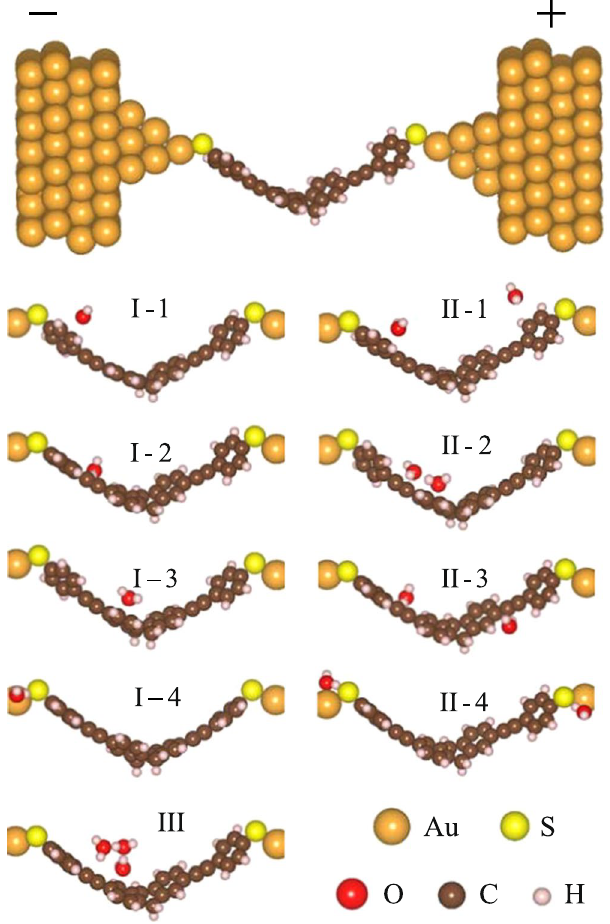
Figure 1. Schematic structures of TADHA molecular junctions with H 2 O molecule being adsorbed on different